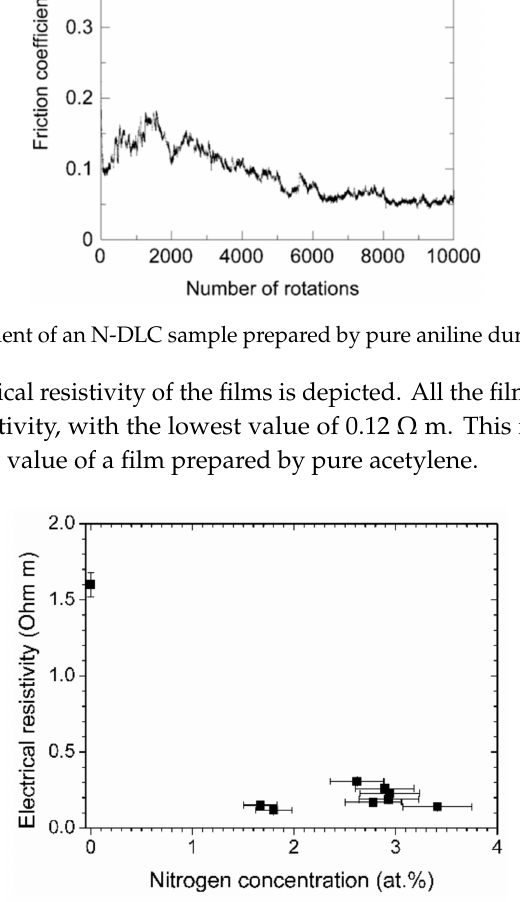
Figure 10. Electrical resistivity vs. nitrogen concentration of the (N-)DLC